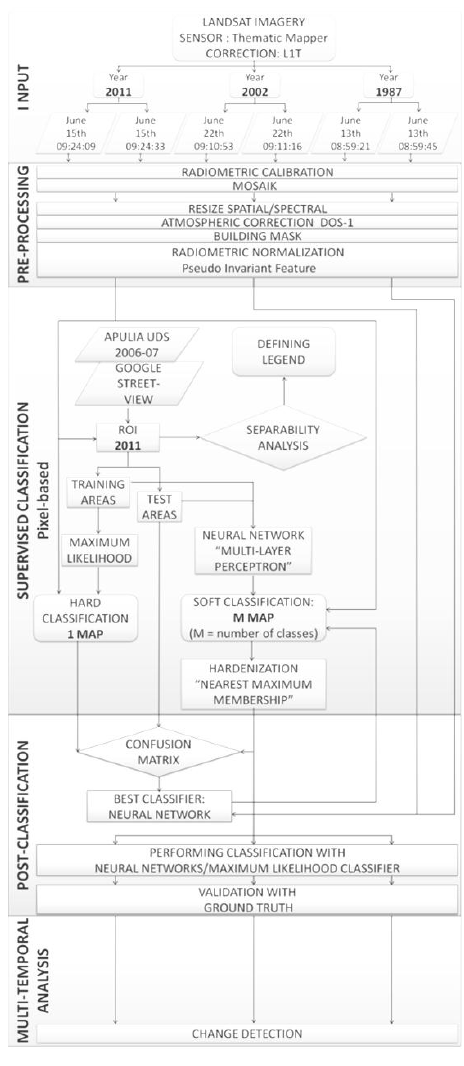
Figure 2. Workflow of the implemented